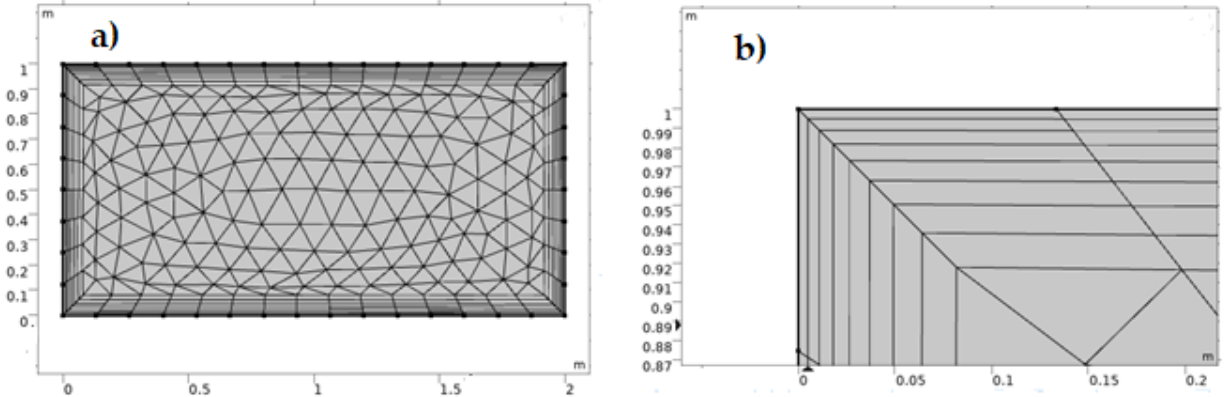
Figure 2. ( a ) Mesh geometry using the boundary layer mesh and ( b ) illustration of the actual structure of the boundary layer mesh.